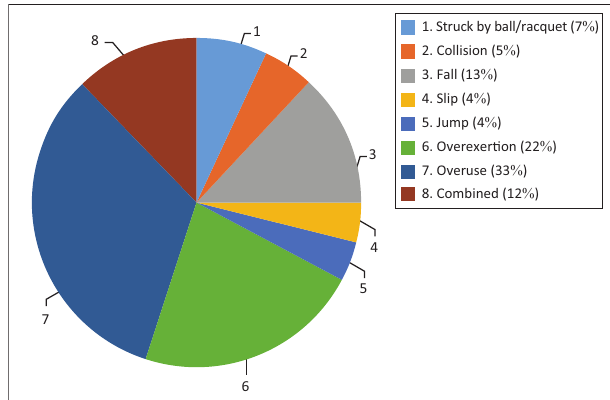
FIGURE 1: Mechanism of injury.